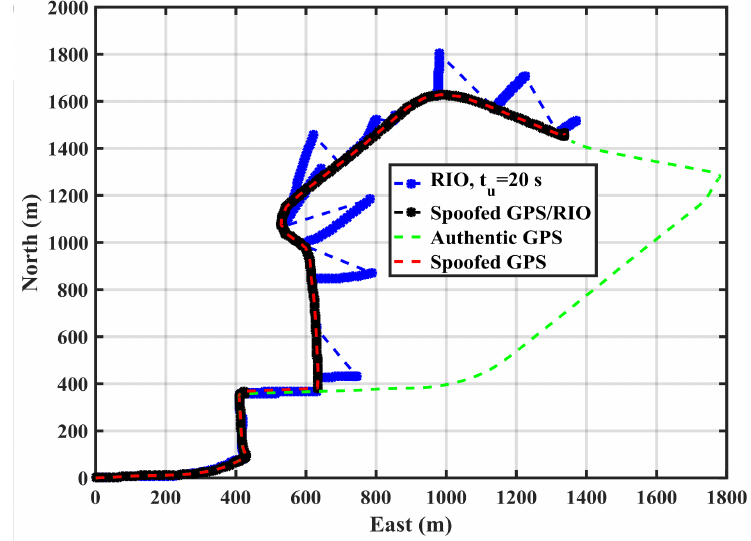
Figure 8. Horizontal trajectories for spoofed GPS, GPS/RIO, RIO with 20 s correction updates for MEMS (cell phone)